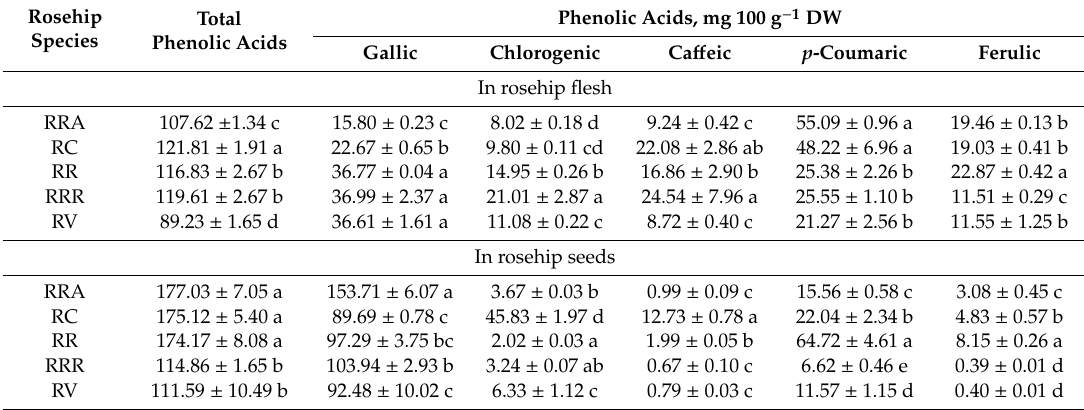
Table 2. Phenolic acid (mg 100 g − 1 DW) of di ff erent organic rosehip flesh and seed species. Rosehip